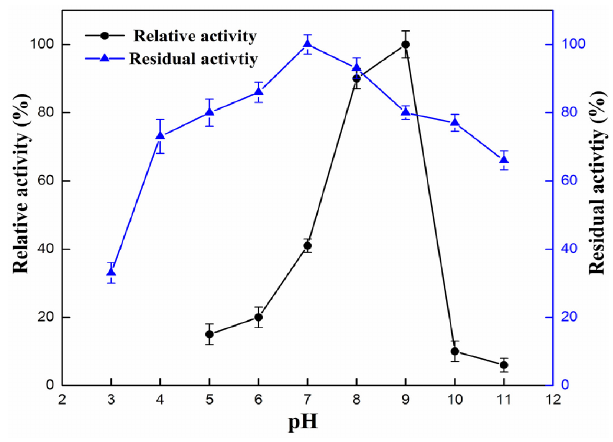
Figure 3. Influence of pH on rProROL activity and stability. The lipase activity was measured with a pH-stat (Metrohm), using olive oil as substrate. Optimal pH was determined by assessing the activity of the purified rProROL at pH 5.0–11.0. The relative activity at different pH values was calculated by setting pH 9.0 as 100%. The pH stability was determined by measuring the residual enzyme activities after incubating purified rProROL at various pH (50 mM acetic acid-sodium acetic acid buffer (pH 3.0–5.0), 50 mM Na HPO -NaH PO buffer (pH 6.0–7.0), 50 mM Tris-HCl buffer (pH 8.0–9.0), 2 4 2 4 buffer (pH 10.0–11.0) for 24 h at 30 °C. The residual activity was calculated by NaHCO 3 taking the activity of purified rProROL without buffer treatment as 100%. All measurements were carried out in triplicate.